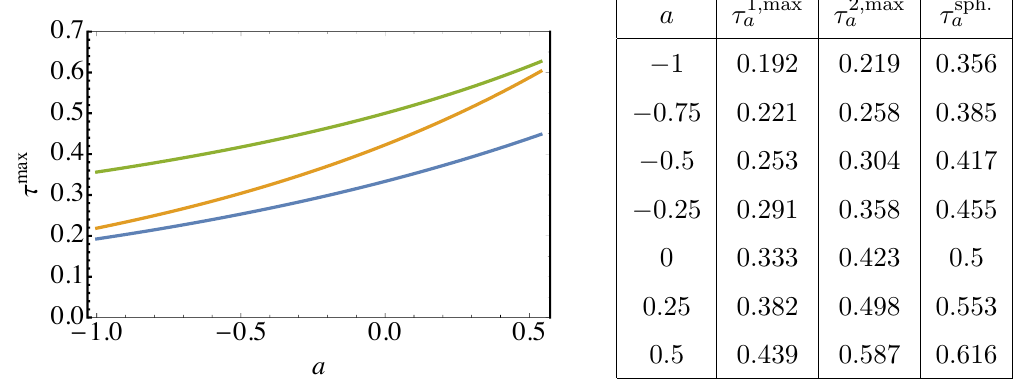
Figure 20 . The maximum values of (cid:28) a for the three-particle (blue), four-particle (orange) and spherical distribution of particles (green) as a function of a